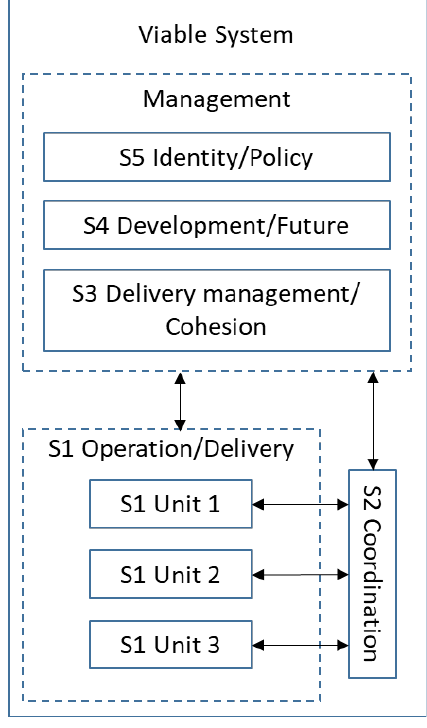
Figure 2. A simplified diagram of VSM